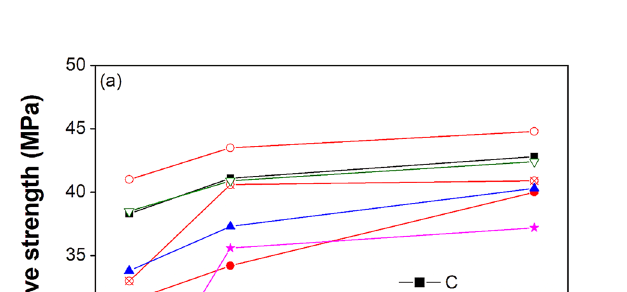
determine the maximum replacement percentage of cement that does not compromise the strength. The concrete specimens were all water cured at a standard curing temperature of 20 °C until the age of testing. The results show that the binary concrete containing 20% BA exhibited highest compressive strengths among all mixes, including those of the CC, irrespective of aging. However, the compressive strength of the other two binary mixes containing BA alone was lower than that of CC at all ages. However, the reduction was more sig- nificant for the binary mix containing a low percentage of BA (10% BA) than for the binary mix containing a higher percentage of BA (30% BA). The low compressive strength of the binary mix with only 10% BA is due to